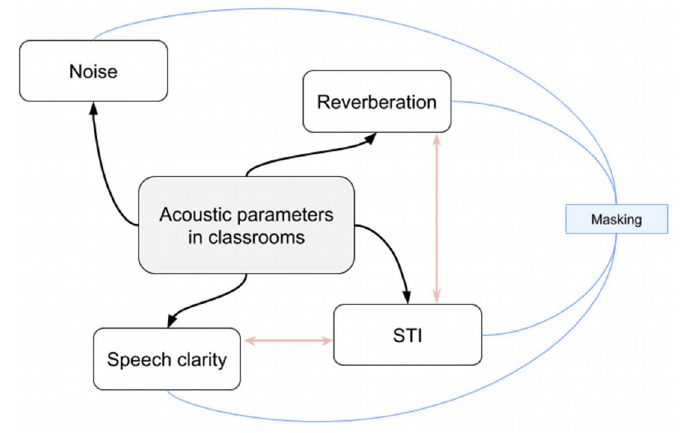
Figure 1. Main relationship between the themes